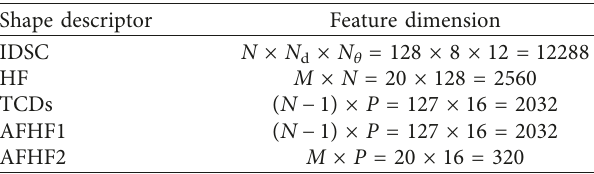
Table 1: Dimension comparison of different descriptors feature